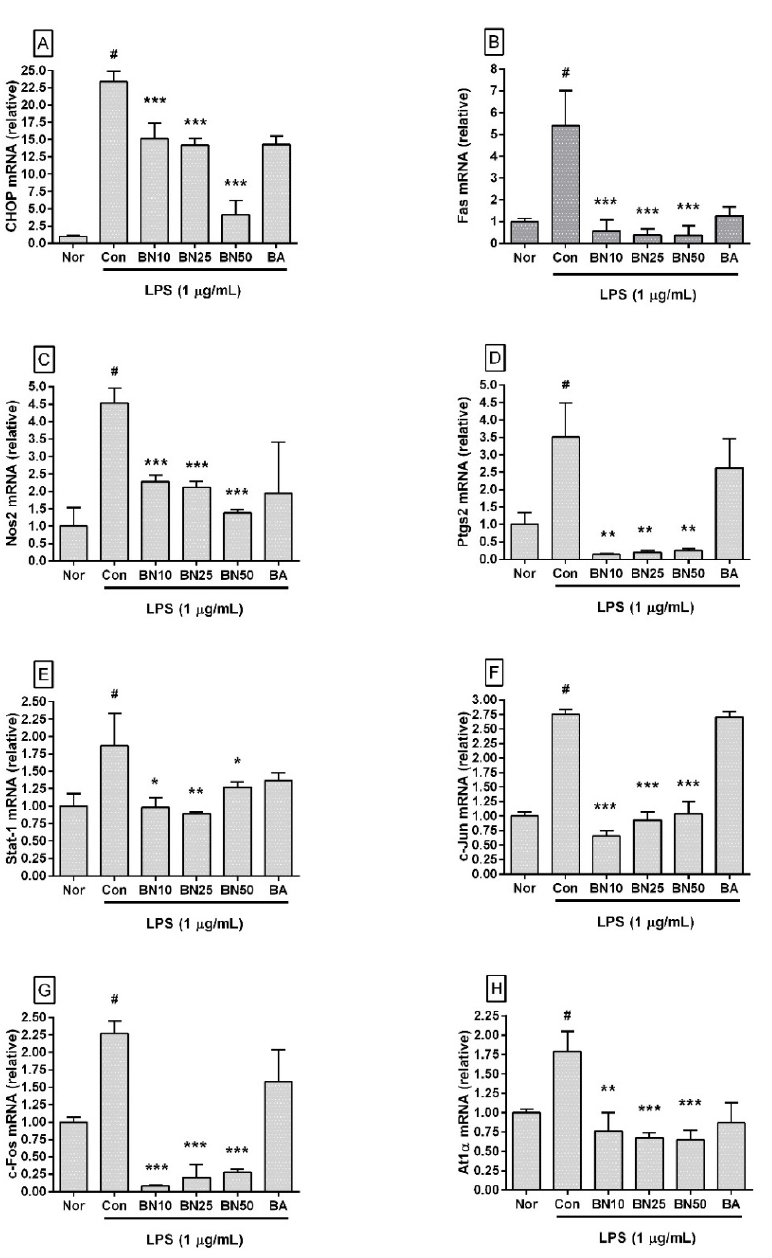
Figure 5. Effect of baicalin on the mRNA expression levels of Chop ( A ), Fas ( B ), Nos2 ( C ), Ptgs2 ( D ), Stat-1 ( E ), c-Jun ( F ), c-Fos ( G ), and At1 α ( H ) in RAW 264.7 macrophages. Values are presented as the mean ± SD of three independent experiments. Nor, normal group incubated with media only; Con, control group treated with 1 µ g/mL of LPS only; BN10, BN25, and BN50 are 10, 25, and 50 µ M of baicalin, respectively; BA, baicalein (25 µ M). # p < 0.001 vs. Nor; * p < 0.05 vs. Con; ** p < 0.01 vs. Con; *** p < 0.001 vs. Con.